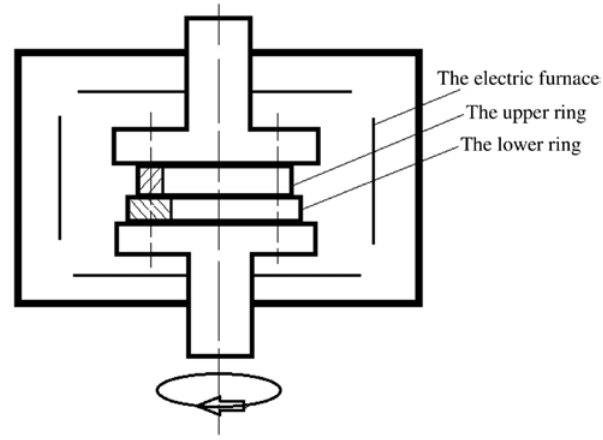
Figure 1: Schematic diagram of the ring-on-ring friction and wear